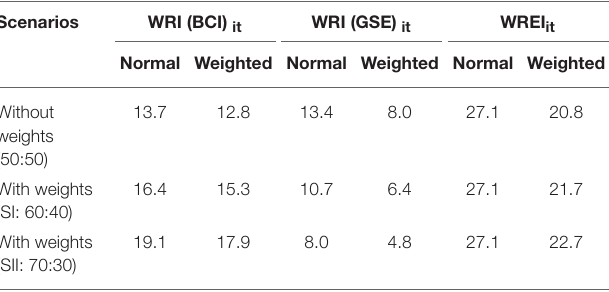
TABLE 4 | Wastewater reuse effectiveness index developed based on data for India (WREI).